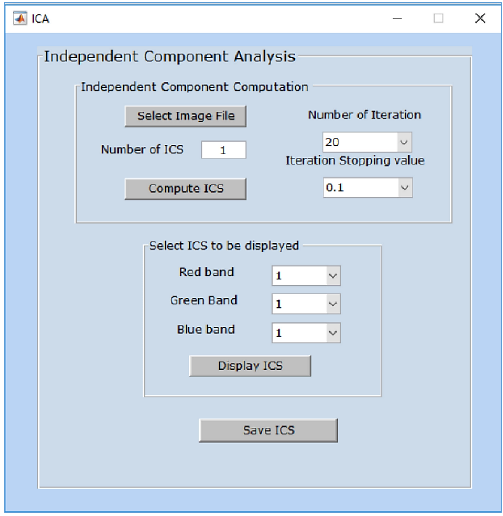
Figure 8. The interface of the ICA sub-module of the classification module of the HICF package.